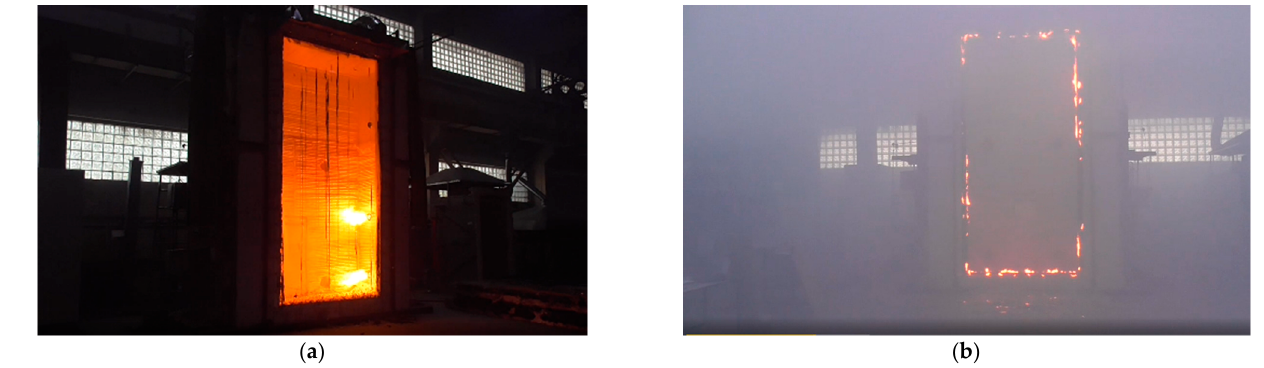
Figure 6. Large-sized sample No. 2.2 ( a ) during fire exposure and ( b ) at the end of fire exposure. Photo by the authors.